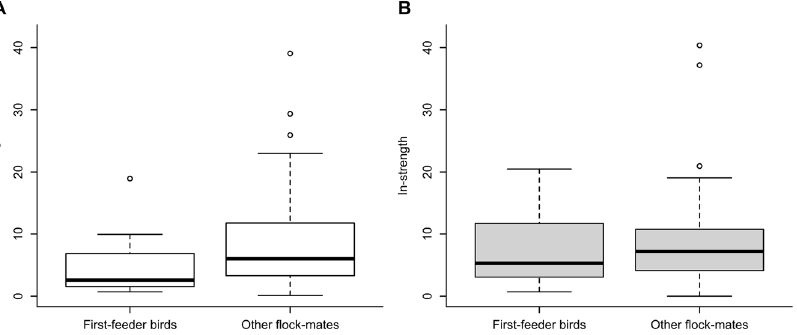
Figure 2. Differences in out-strength and in-strength between the first-feeder birds and other birds in the flocks. Out-strength ( A ) was calculated from the number of followings per hour when the focal bird followed a flock-mate to the feeder during the pre-training period, whereas in-strength ( B ) was derived from the number of followings per hour during which the focal bird was the initiator individual. These metrics were derived from the constructed following networks and reflect individuals’ social position (in terms of their tendency to follow others and elicit followings from others, respectively) in their flock. Horizontal lines are medians, the boxes and the whiskers show the interquartile ranges and the data ranges,